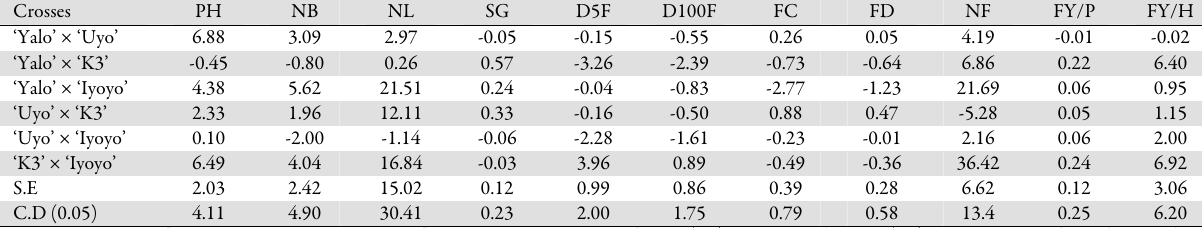
Table 5. Specific combining ability estimate on the agronomic traits of hybrid eggplant genotypes Crosses ‘Yalo’ × ‘Uyo’